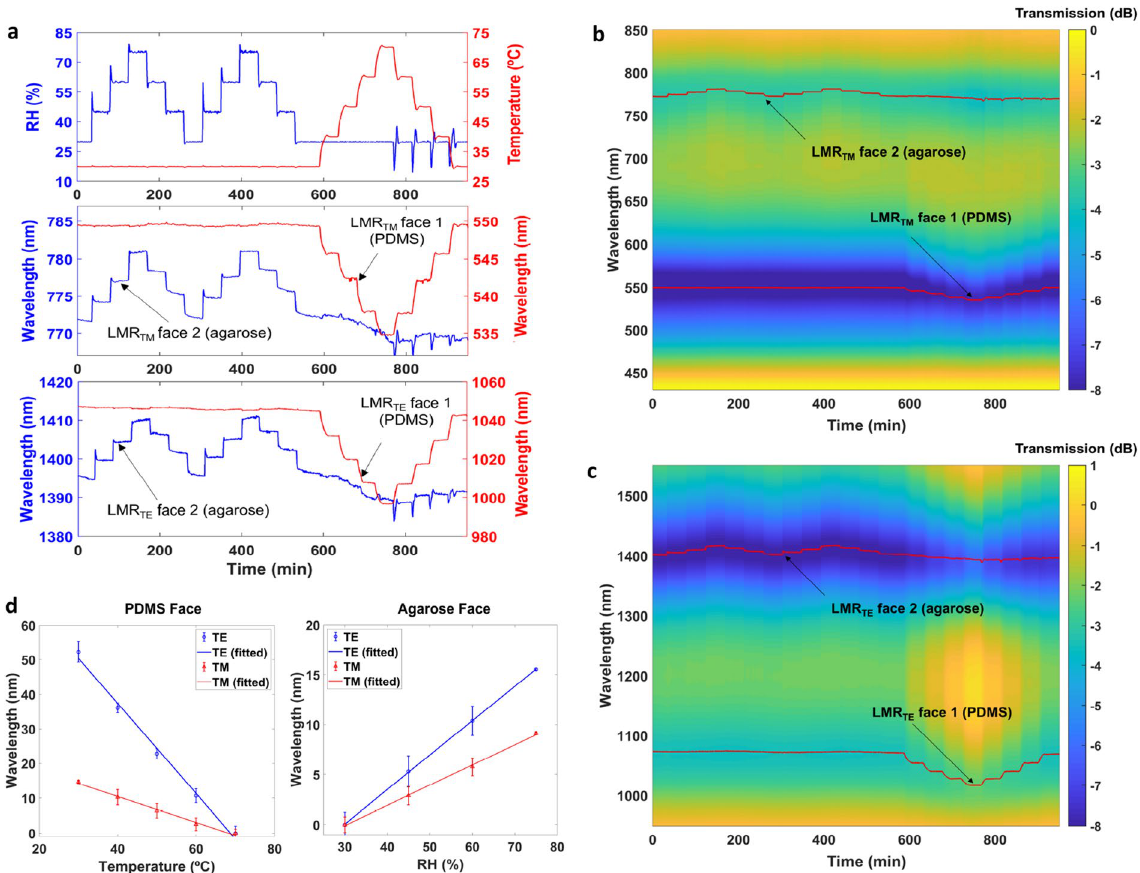
Figure 4. Humidity and temperature response of the sensor. ( a ) Humidity and temperature values registered by the electronic sensor compared with the wavelength shift in the visible and in the NIR range of the LMR TM and LMR TE generated by face 2, coated with agarose, and of the LMR TM and LMR TE generated by face 1, coated with PDMS. ( b ) Spectral evolution in the visible range of the optical sensor. ( c ) Spectral evolution in the NIR range of the optical sensor. ( d ) Relative wavelength shift as a function of temperature and humidity for both LMR TE (NIR) and LMR TM (visible), induced by face 1 (PDMS) and by face 2